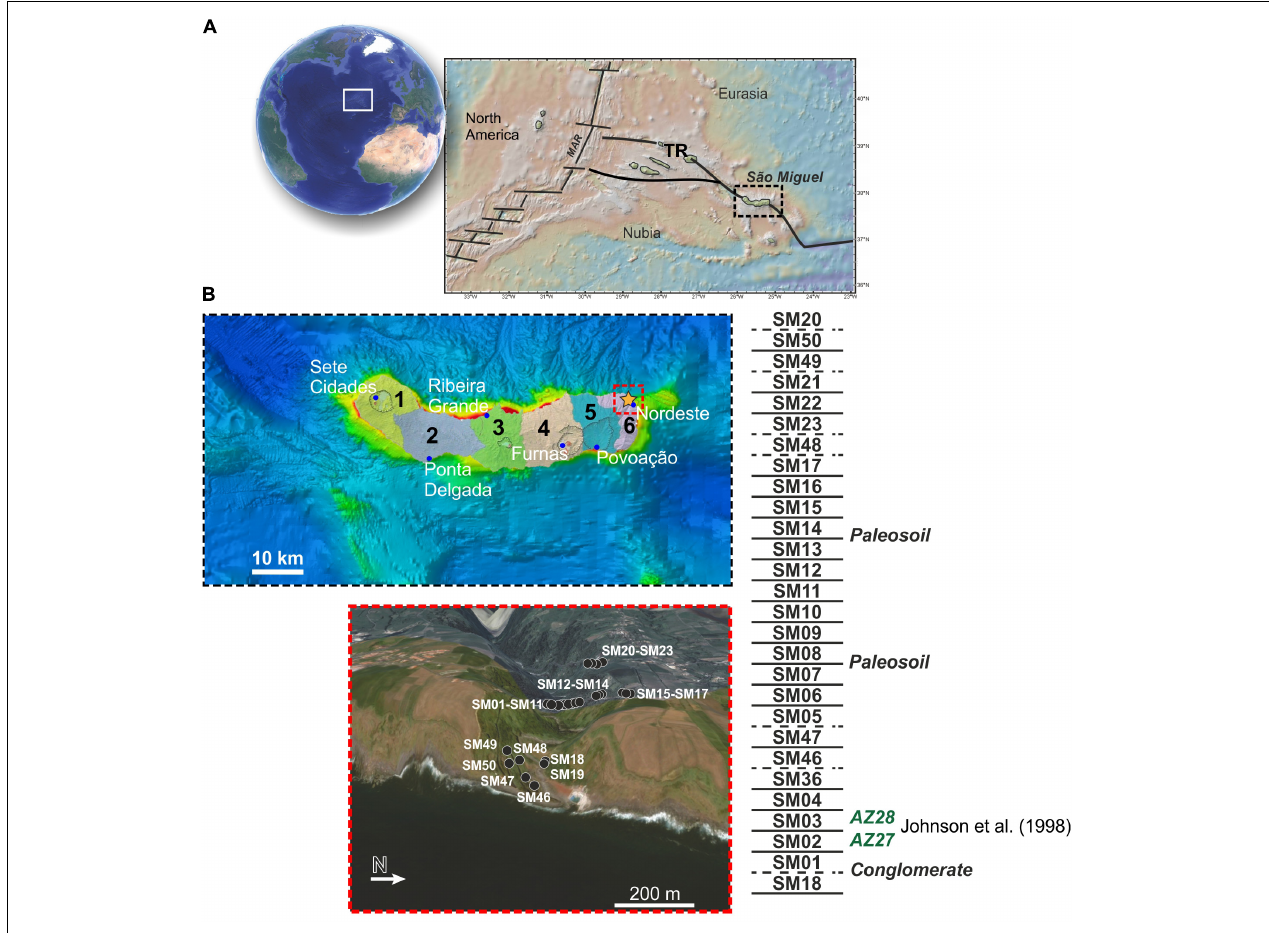
FIGURE 1 | Regional setting of the study area. (A) location of the Nordeste section (yellow star) within São Miguel Island and position of the samples studied throughout the valley; (B) stratigraphic succession of the